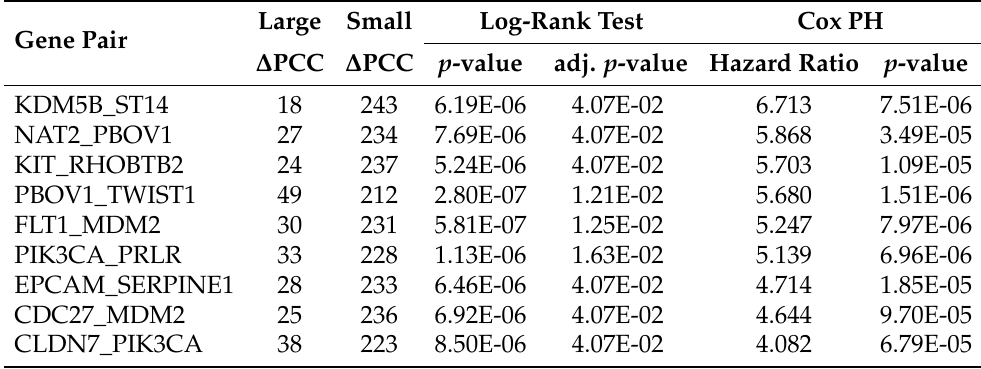
Figure 3. Kaplan–Meier plots for the gene pairs selected by the log-rank test [24]. ( A ) The highest hazard ratio of gene pair MAPK10_PTK6 for prognosis of survival of wtTP53 (left plot). ( B ) The highest hazard ratio of gene pair KDM5B_ST14 for prognosis of survival of mTP53 ( left plot ). The Kaplan–Meier plots of the same gene pairs are displayed for the other group ( right plots ) for comparative purposes. Table 3. Gene pairs with the highest hazard ratio in